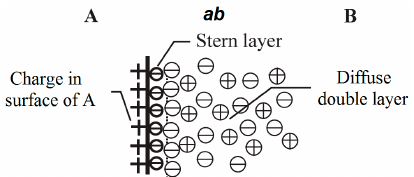
Figure 11. Distribution of the electrical potential in Stern layer and Gouy-Chapman diffuse mobile ion double layer of the interface ab in response to a charge A (© IOP Publishing. Reproduced with permission. All rights reserved